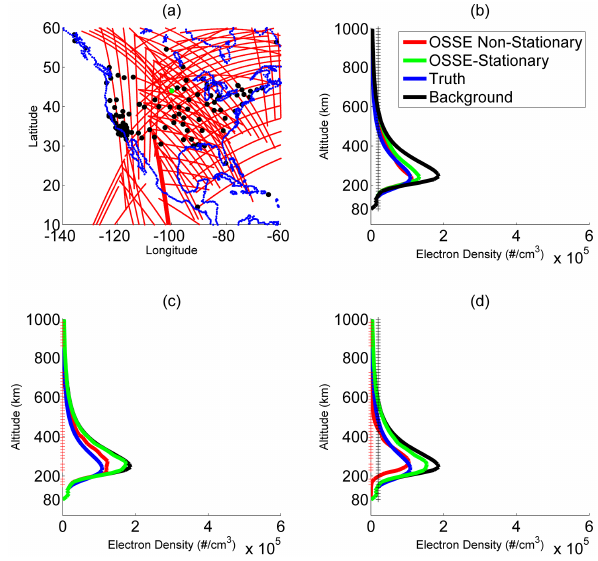
Figure 3. The OSSE result of the data assimilation model for 00:00UTC on 5 February 2008. (a) The F3/C RO slant TEC paths of assimilated observations are shown as the red line, the black points are the ground-based GPS stations used in the OSSE. The data are accumulated over 1h. The green dot indicates a loca- tion where electron density profiles are sampled for comparison and validation. (b) The electron density profiles are sampled from OSSE DA results obtained by assimilating the synthetic ground- based GPS data, which is integrated from the OSSE truth with dif- ferent covariance models. The red line indicates the OSSE DA re- sult with a location-dependent model error covariance (computed from EOFs), the green line is the OSSE DA result with a location- independent model error covariance (Gaussian), the blue line is the OSSE truth, and the black line is the background model. (c) The same as (b) but OSSE DA results are obtained by assimilating the synthetic F3/C data. (d) The same as (b) but OSSE DA results as- similated the synthetic data obtained from ground-based GPS and F3/C data. Note: the marks on the y axis indicate altitudes where slant TEC paths pass through this validation location, where red is used for F3/C and black is for ground-based GPS